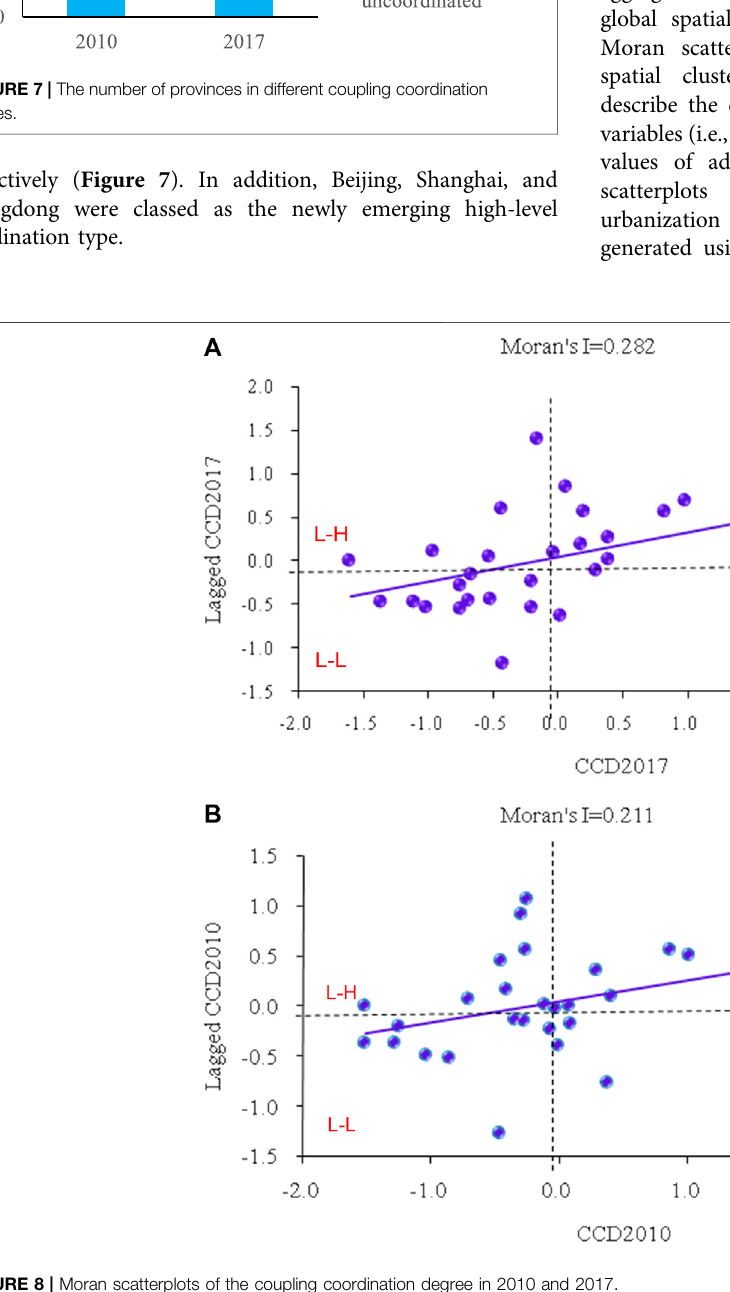
Frontiers in Environmental Science |